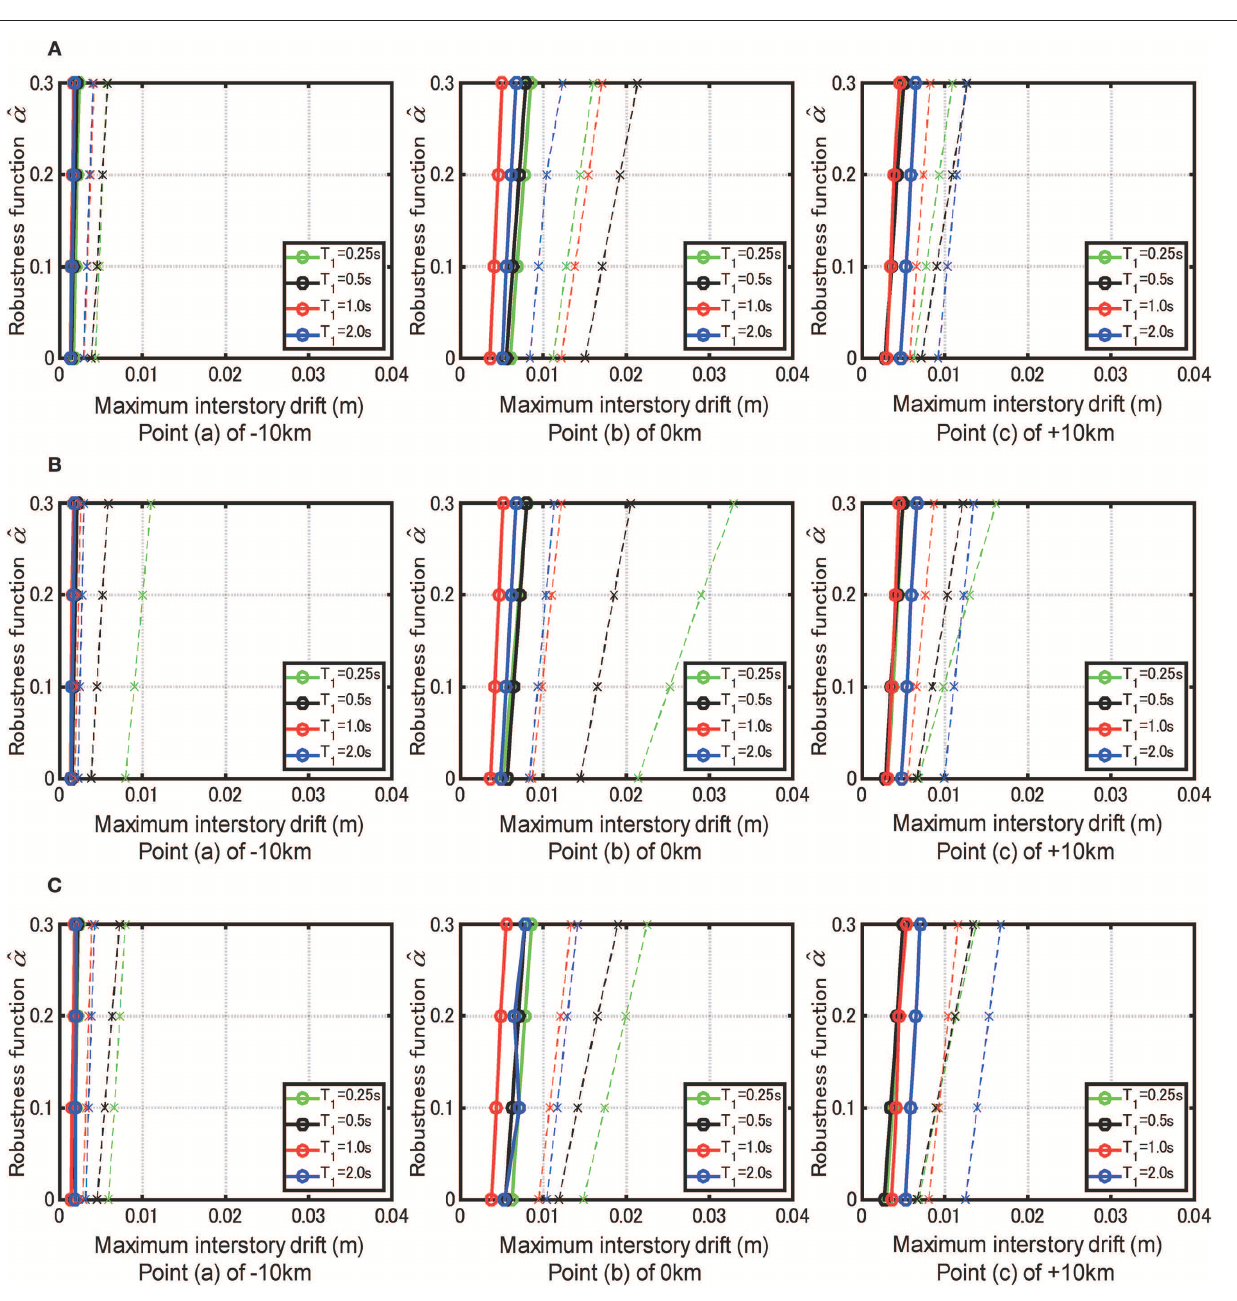
FIGURE 13 | Robustness function ˆ α with respect to the maximum interstory drift of four MDOF models with different numbers of stories ( T 1 = 0.25 s ,0.5 s , 1.0 s , 2.0 s ) at three points. (A) Model with straight lowest natural mode. (B) Model with trapezoidal stiffness distribution. (C) Model with uniform stiffness distribution (solid line: with damper, broken line: without